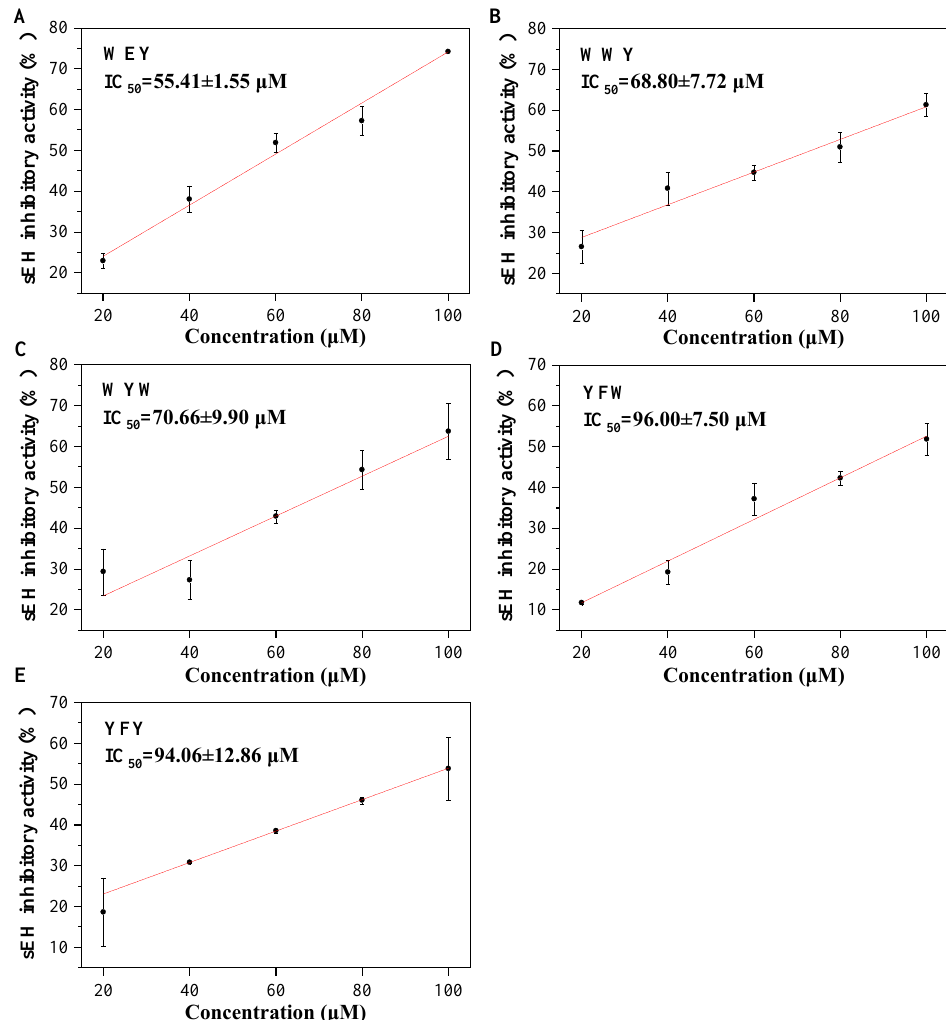
Figure 2. The sEH inhibitory activities of peptides WEY ( A ), WWY ( B ), WYW ( C ), YFW ( D ), and YFY ( E ).